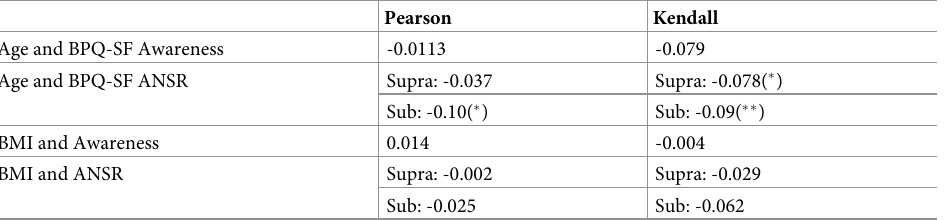
Table 5. Pearson and Kendall’s correlation